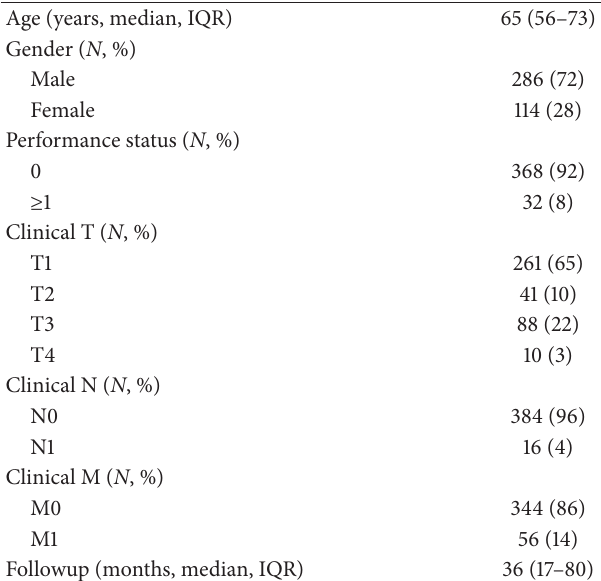
Table 1: Patient characteristics.